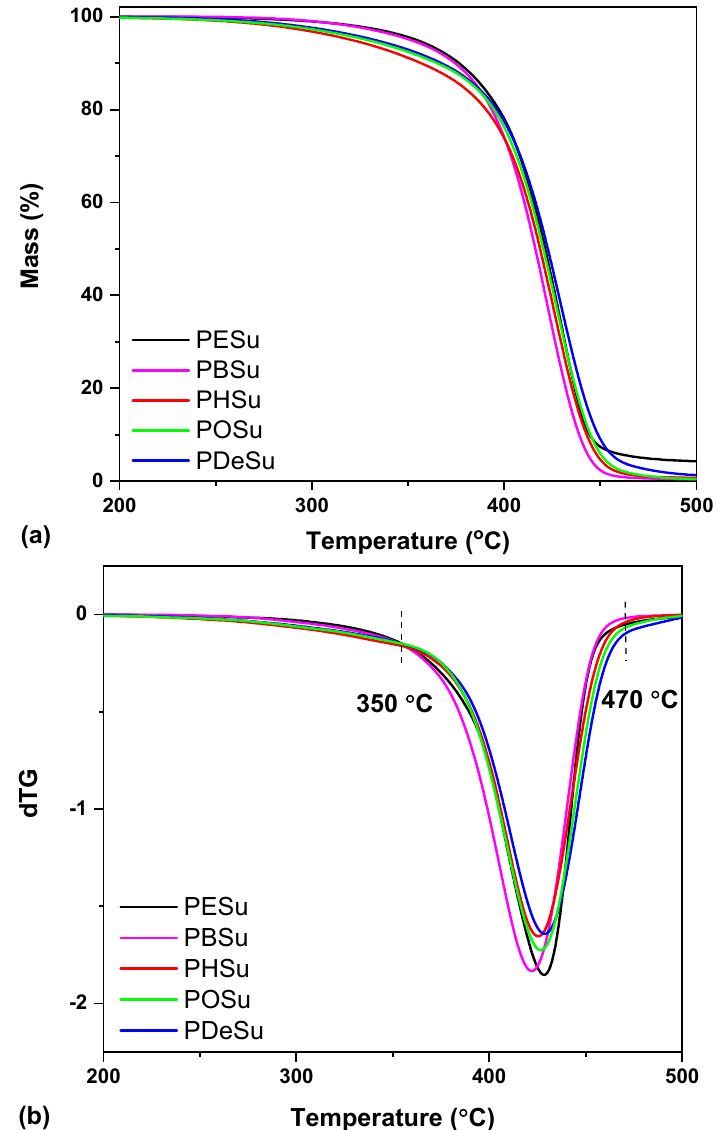
Figure 1. TGA thermograms of the synthesized poly(alkylene succinate)s. ( a ) Remaining mass (%)